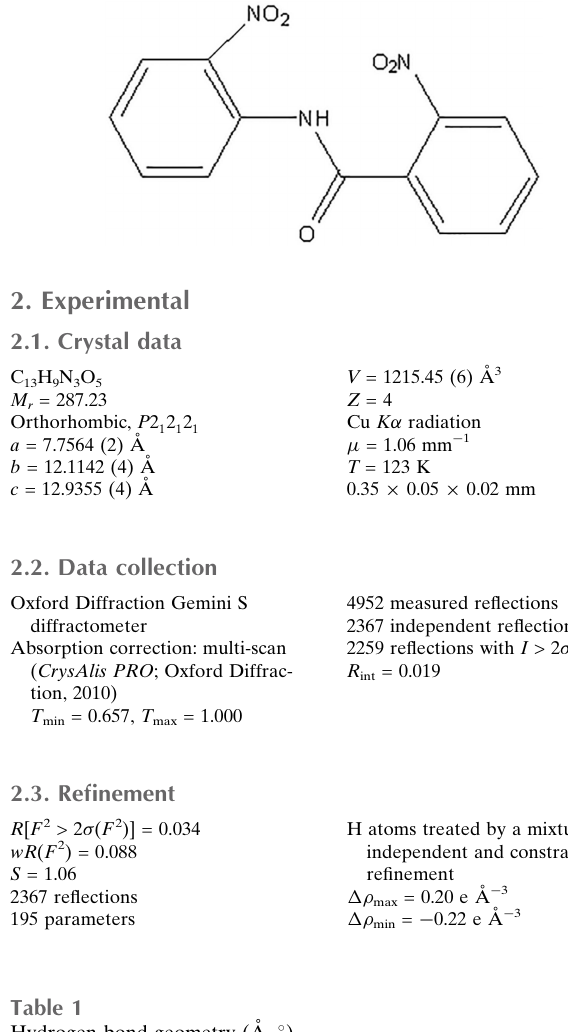
Hydrogen-bond geometry (A˚ , (cid:2)